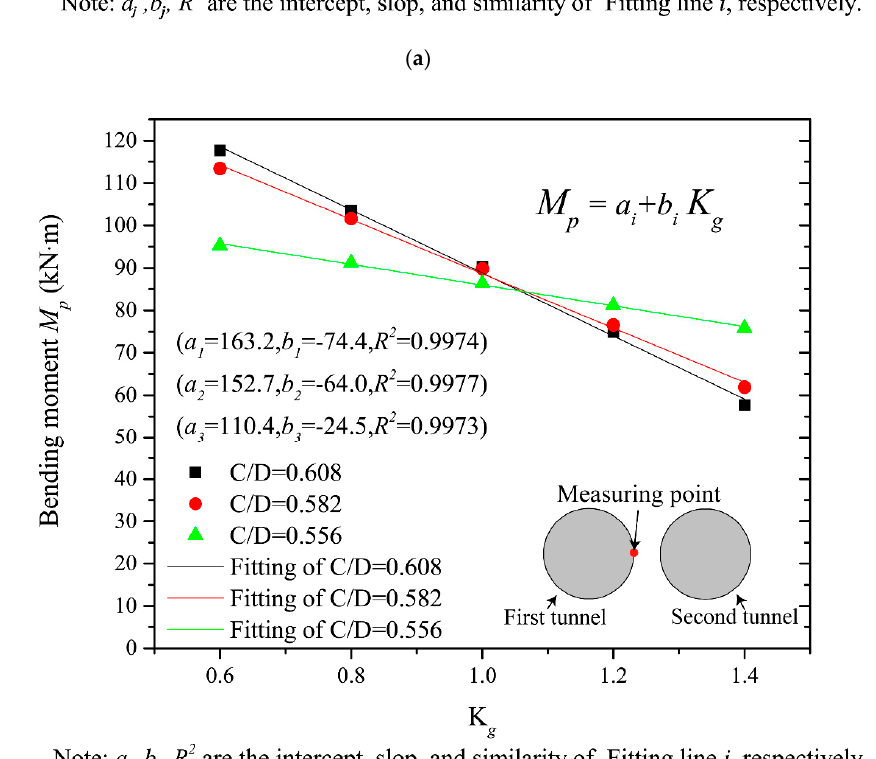
Figure 14. Influence of grouting pressure on lining bending moment in different cases: ( a ) the minimum negative bending moment at ER60 top; and ( b ) the maximum positive bending moment at ER60 sidewall.